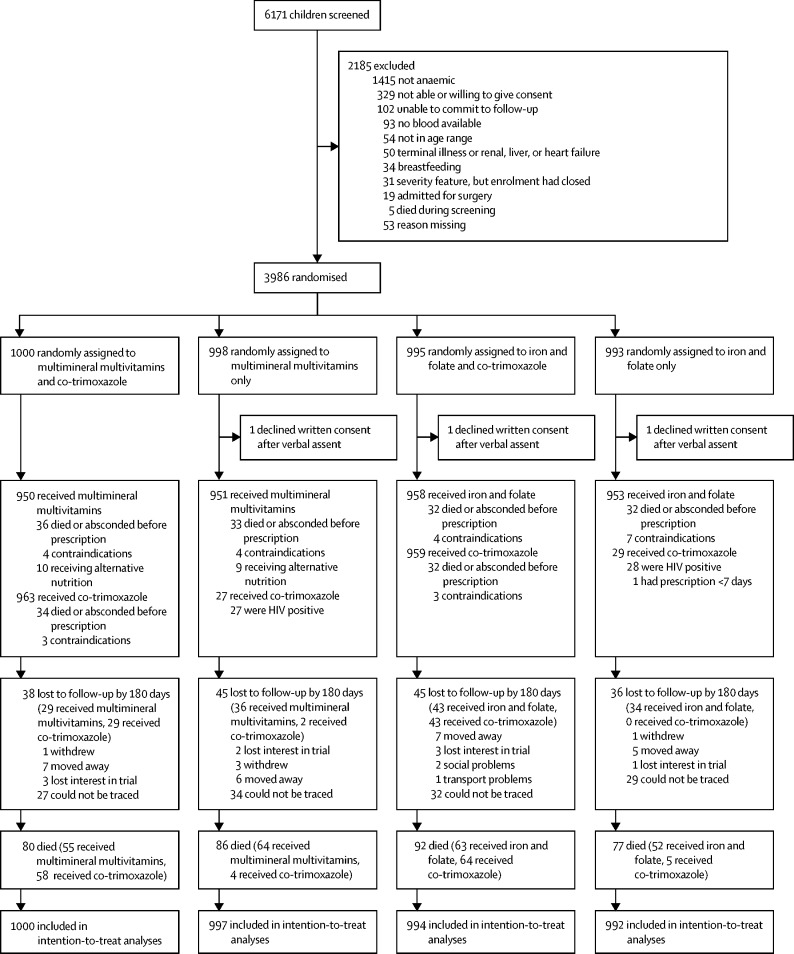
Trial profileAll children for whom co-trimoxazole prophylaxis should have been prescribed according to WHO or national guidelines (eg, HIV-infected children) received it regardless of randomisation.